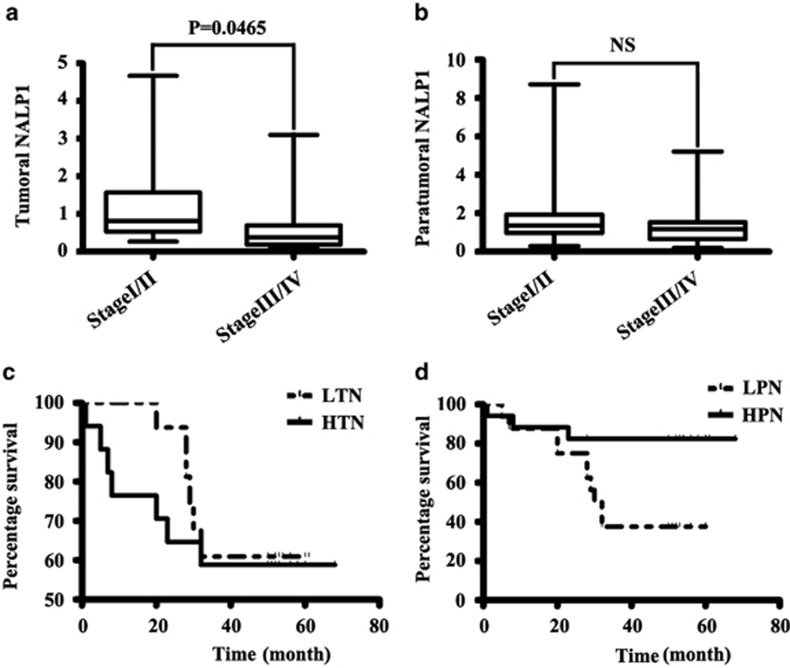
The staging and survival analyses. (a) T test of NALP1 expression in tumor tissue between stage I/II and stage III/IV disease. The expression of NALP1 in stage I/II was significantly higher than stage III/IV disease (P=0.0465). (b) T test of NALP1 in paratumoral tissue between stage I/II and stage III/IV disease revealed no significant difference (P=0.2418). (c) Survival analysis of 33 cases. There was no significant difference between the two groups. HTN, higher tumor NALP1; LTN, lower tumor NALP1. The P-value was 0.6443. (d) Survival analysis of 33 cases. The difference between the two groups is significant. HPN, higher paratumoral NALP1; LPN, lower paratumoral NALP1. The P-value was 0.0199